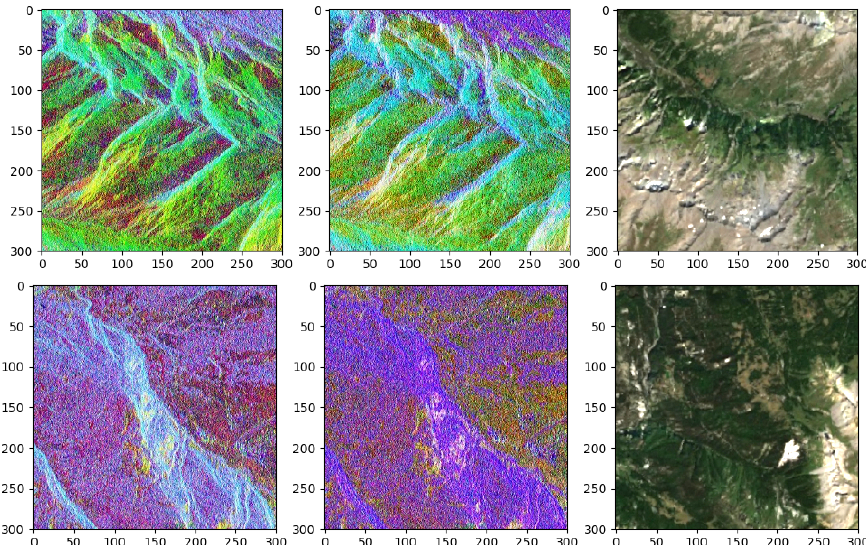
Figure 10. Extract of visualization on the time-series by CAE on the left, PCA on middle. The image on the right corresponds to the Sentinel-2 extract on the footprint selected